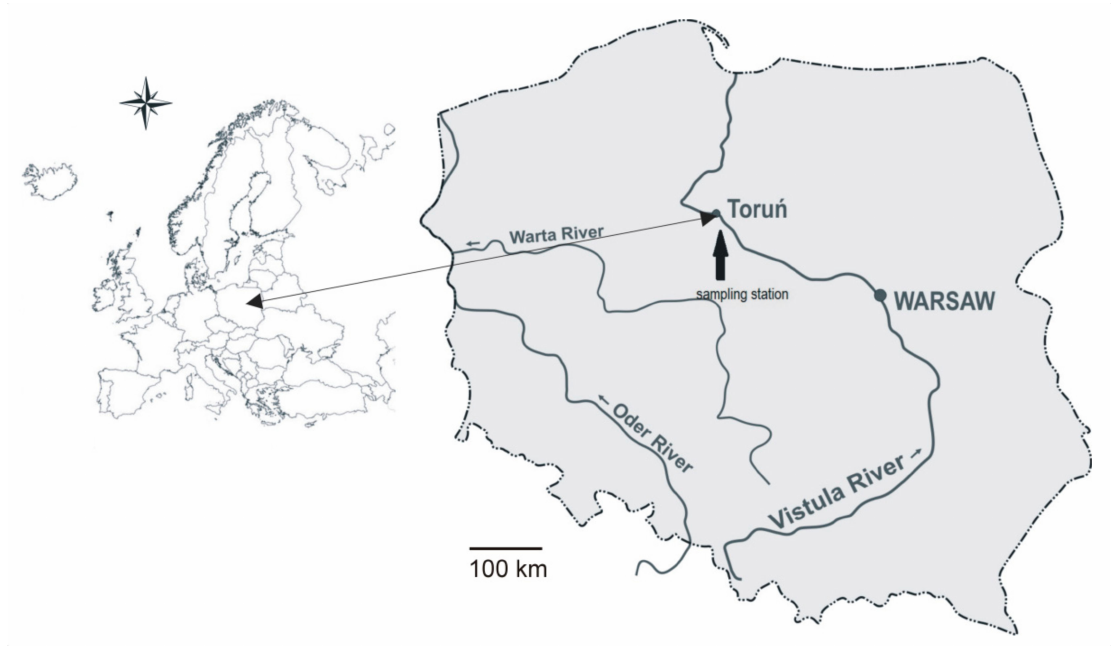
Figure 1. Location of the investigated station on the Vistula